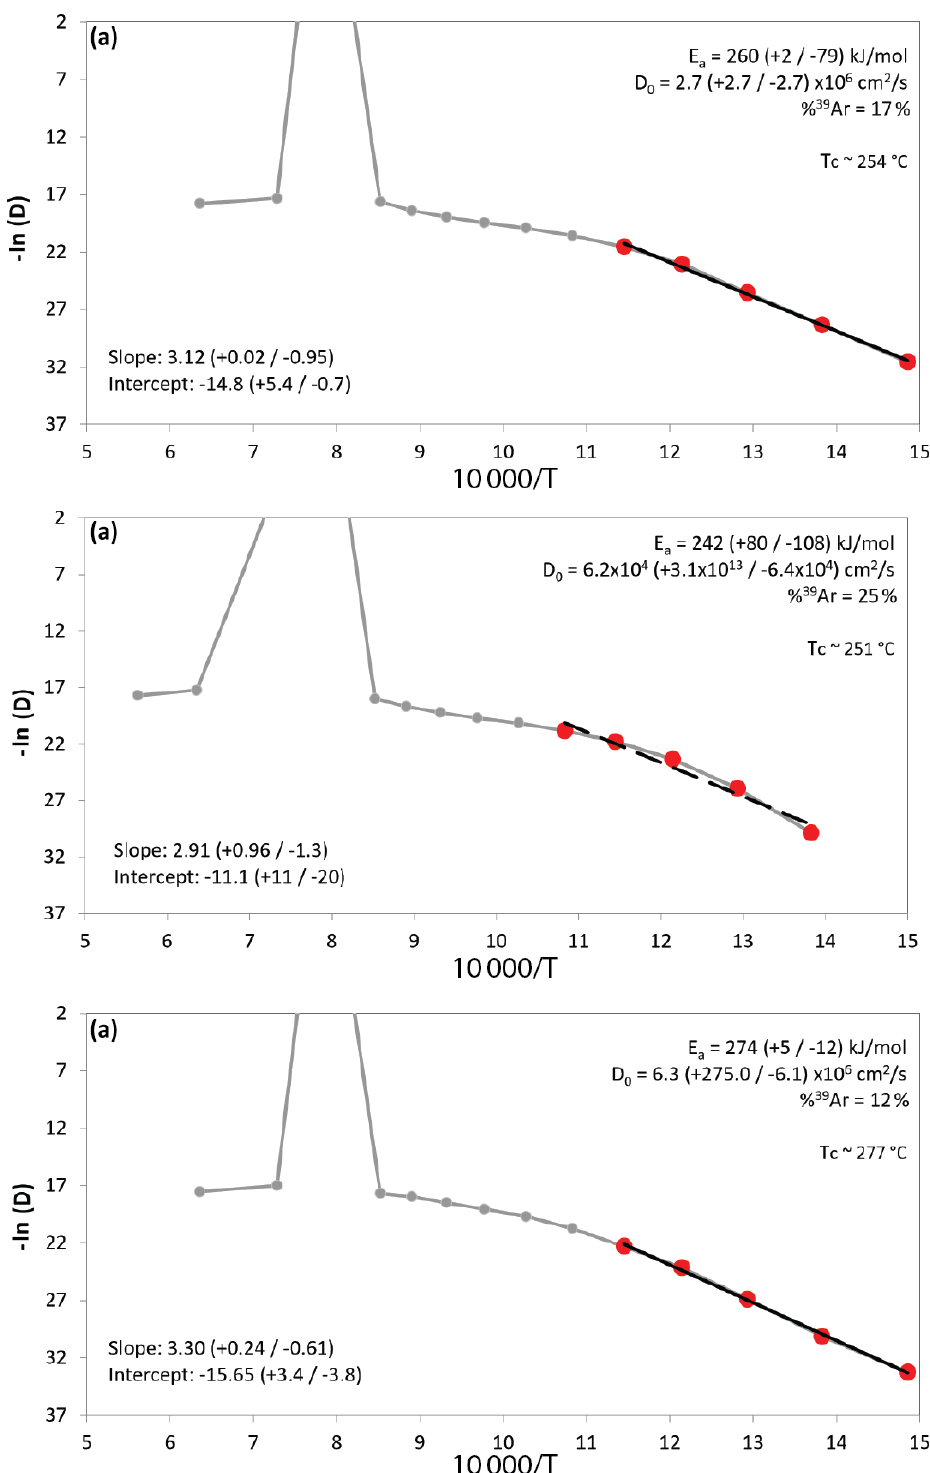
Figure 7. Arrhenius plots of argon diffusion coefficients calculated from step-heating experiment data against a reciprocal absolute temper- ature of multi-grain polyhalite aliquots from two samples, SRLR05 (a) and SRLR06 (b, c) . The red dots are the steps used for the regression line (black line) from which the values of E a , D 0 , and T c were